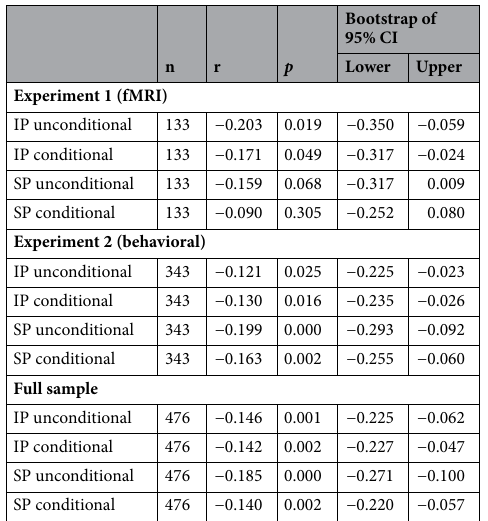
Table 2. Correlations between SIF and MCR on the SP and the IP tests. MCR = Memory Checking Rating; CI = Confidence Interval; bootstrap results are based on 1000 bootstrap samples.